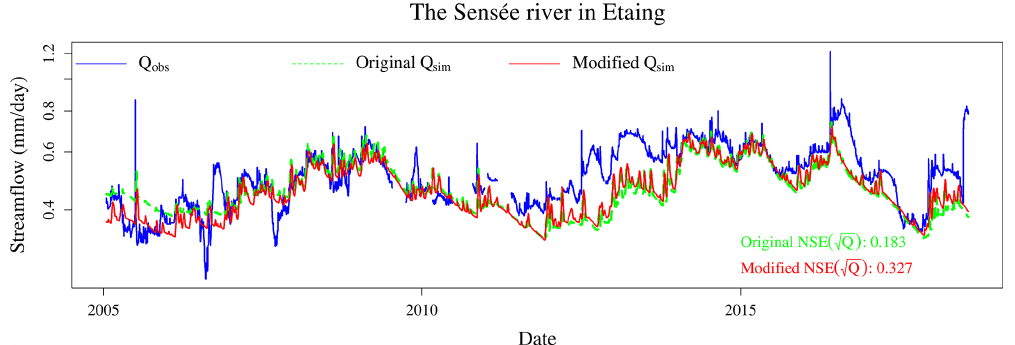
Figure 9. Observed and simulated streamflows of the Sensée River in Étaing, where the simulated streamflow was obtained with the original and the new calibration frameworks. A log scale is used to focus on low flows.